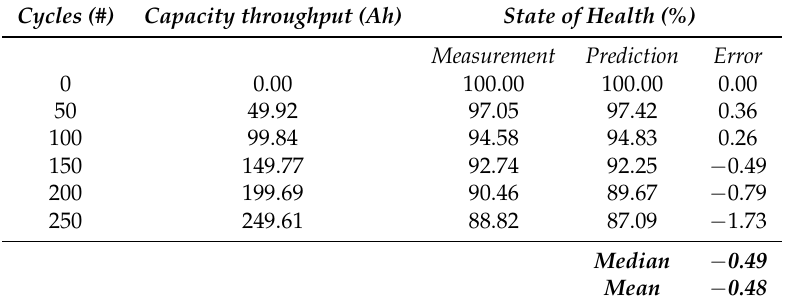
Table 6. Dynamic validation results of the presented capacity fade model based on the WLTP driving profile. Cycles